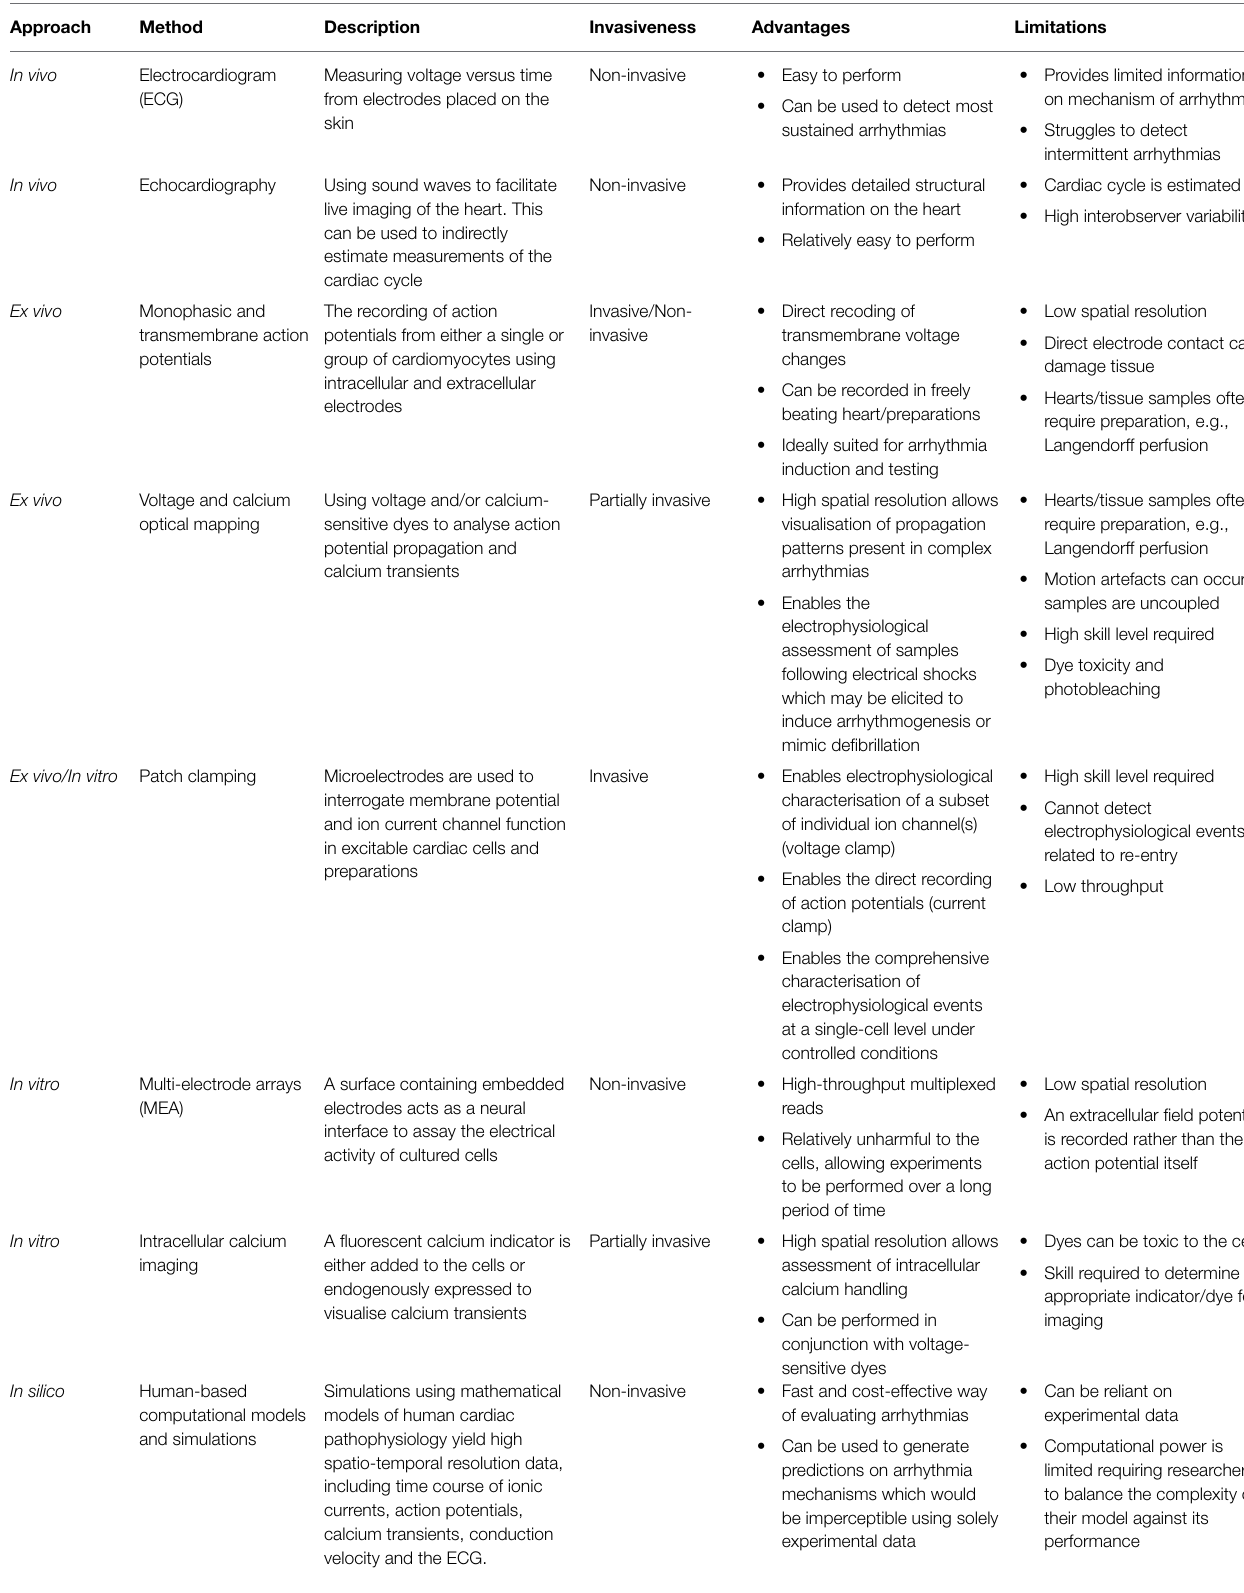
TABLE 1 | Methods used to evaluate cardiac arrhythmia in heart failure.